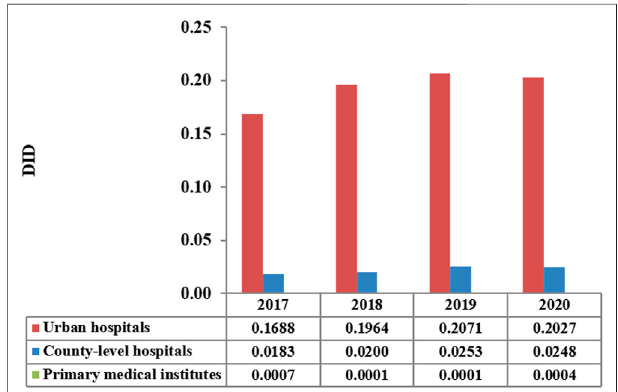
FIGURE 1 | DID of carbapenems by the level of healthcare institution in Shaanxi Province, 2017 – 2020.